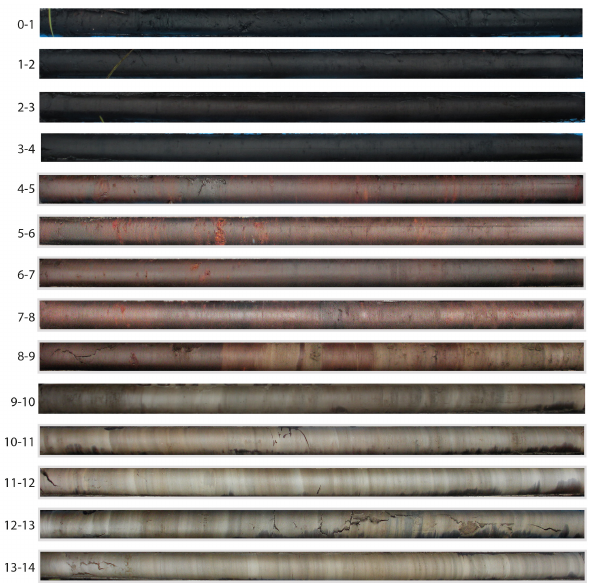
Figure 4. Sediments of the 14 sections of core CO 14-1 showing grey lacustrine deposits below 9m depth, a transition between peat and lacustrine deposits between 9 and 8m, and peat in the upper